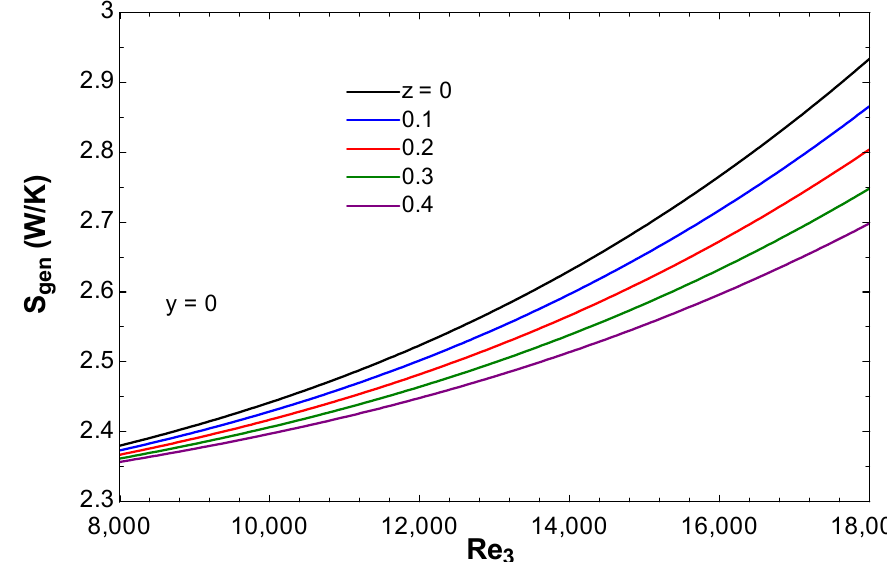
Figure 10. Effect of airflow ratio z and Reynolds number on entropy generation.